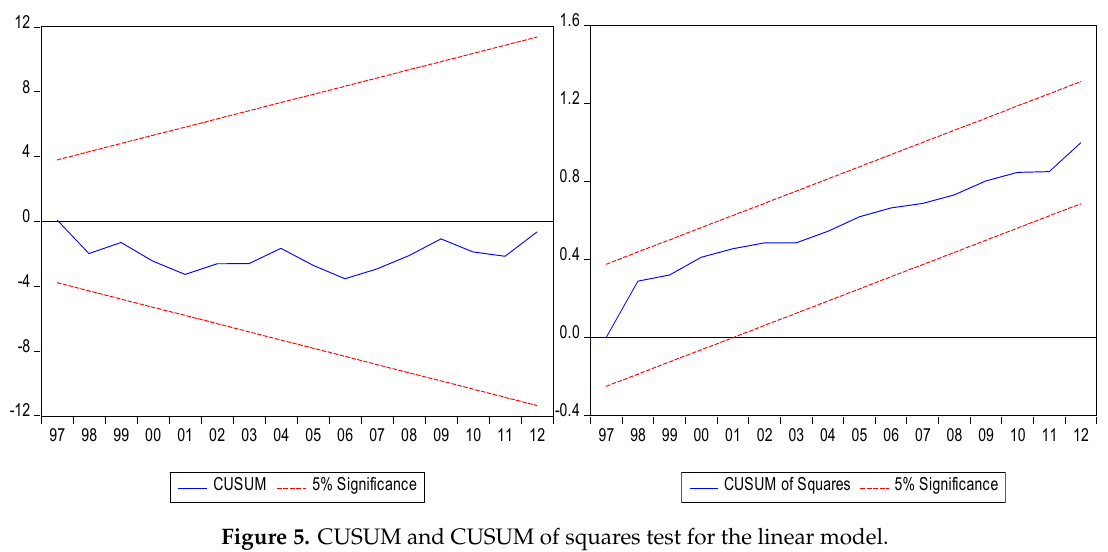
Figure 5. CUSUM and CUSUM of squares test for the linear model.